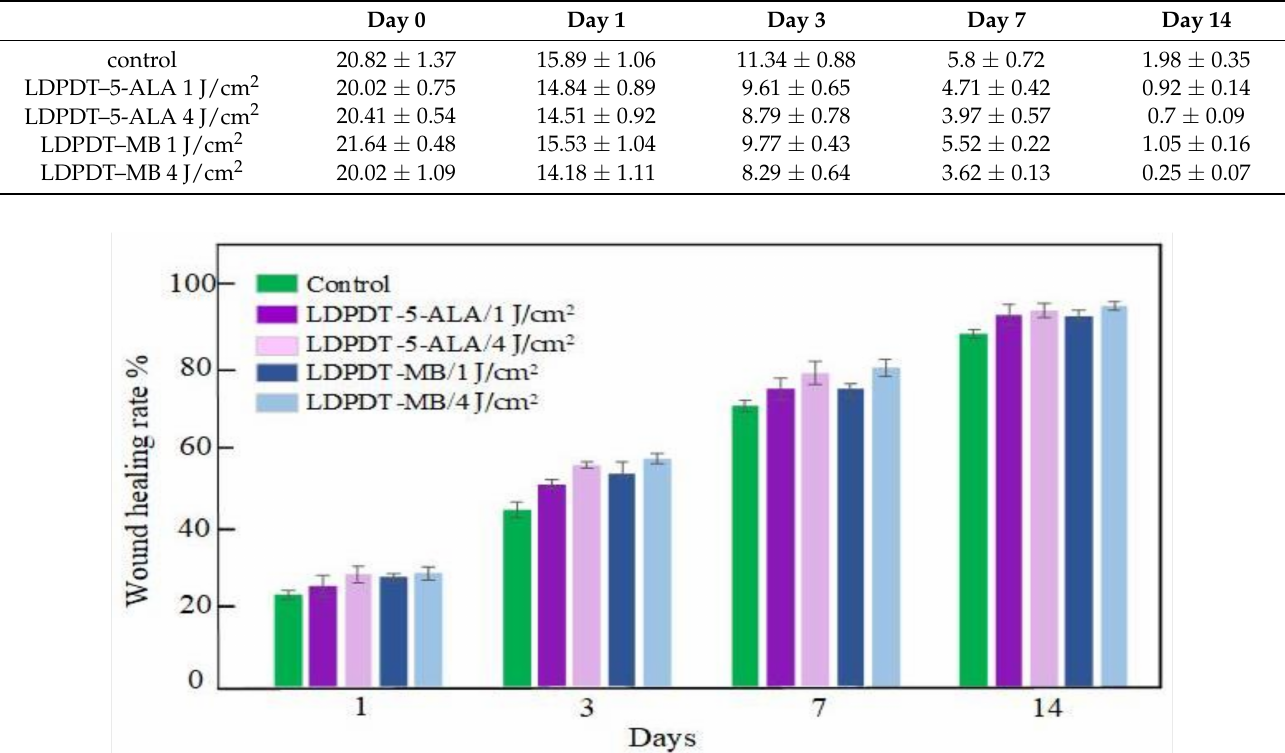
Figure 3. Wound healing